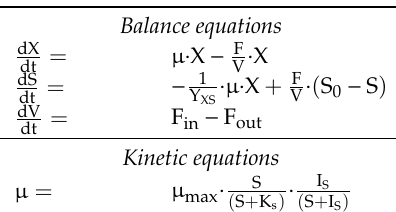
Table A5. Model equations of Model B.